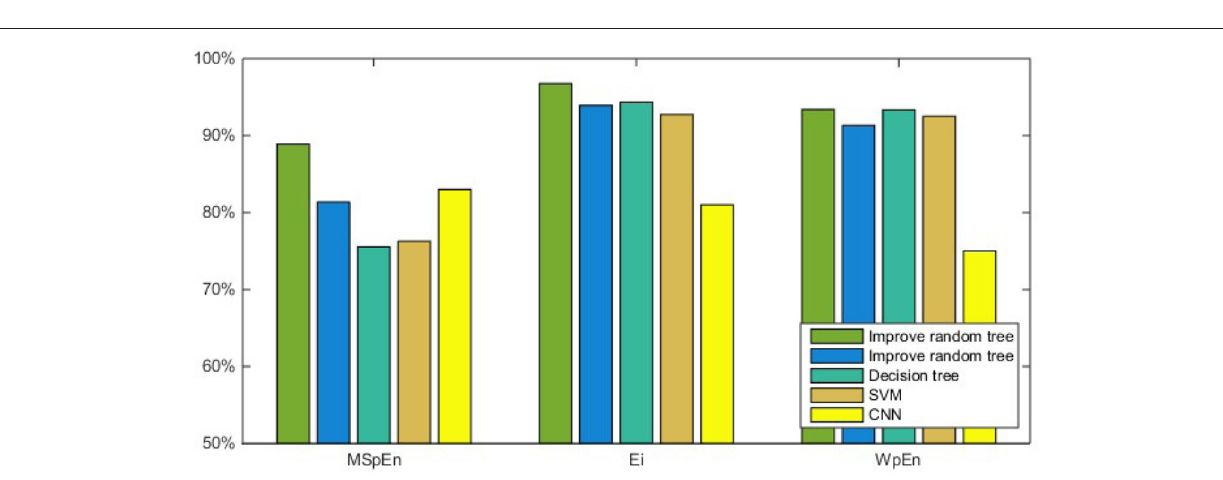
FIGURE 9 | Comparison of the average classification results with other